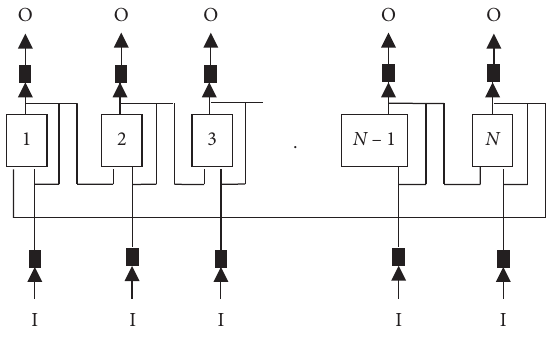
Figure 2: RPLNN structure [13].